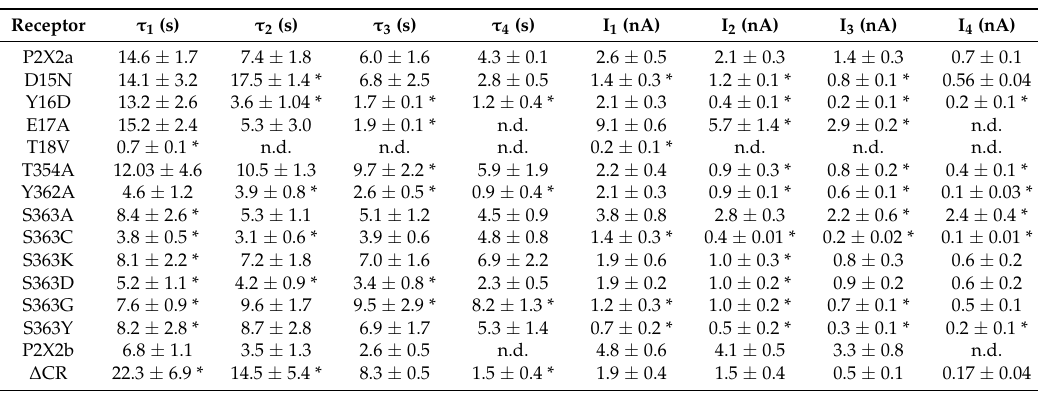
Table 1. Rates of desensitization and maximal currents after repetitive stimulation of the P2X2aR, P2X2bR and mutant P2X2aRs by 100 µ M ATP for 40 s followed by 4-min washout periods. The data are presented as the mean ± standard error values, with n of 3–17 per receptor. The P2X2bR is a splice variant lacking the Val 370 –Gln 438 sequence in the C terminal domain. ∆ CR, Truncated receptor with the C-terminal sequence Val 444 –Leu 472 deleted; n.d. not defined; τ 1 – τ 4 , rates of receptor desensitization and I 1 –I 4 , the peak amplitude of current responses during the four ATP applications. All results are expressed as the mean ± SEM. Nonparametric Mann Whitney-test ( p < 0.01) was utilized to compare the wild type and mutant receptor amplitude responses and desensitization times. Asterisk (*) denotes significant